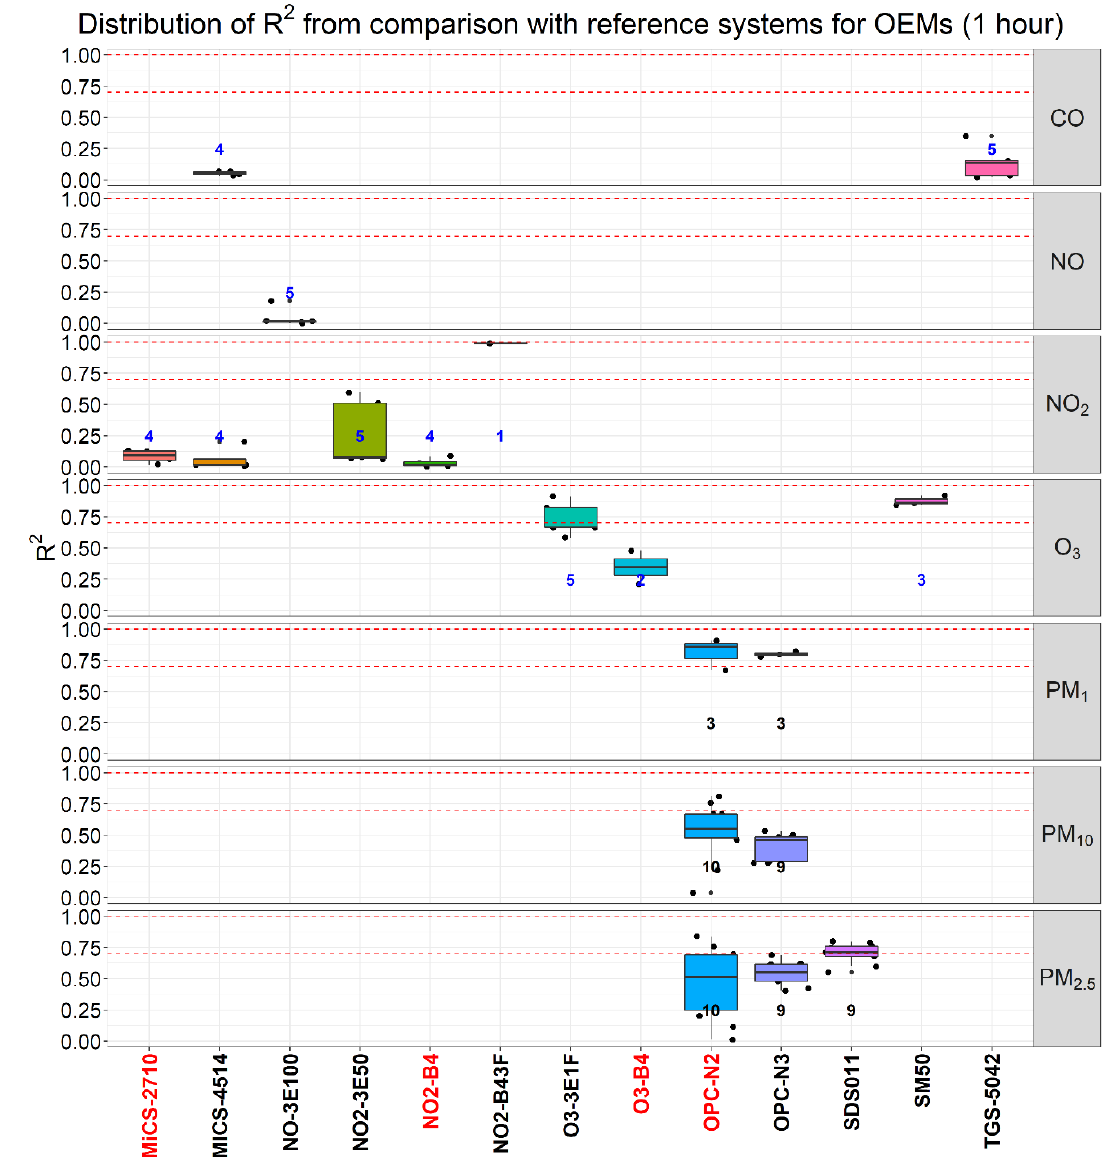
Figure A5. Distribution of R 2 from the comparison of all OEMs against reference systems. Records were averaged over a time-scale of 1 h. Numbers in blue and black indicate the number of open source and black box records, respectively. Names of “living” and “non-living” sensors are indicated by black and red labels on the x-axis, respectively.